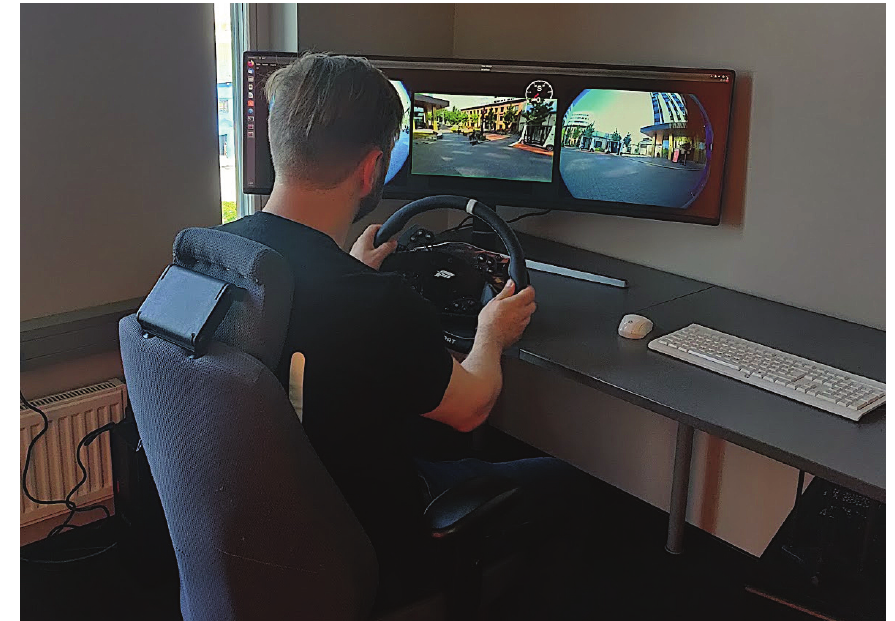
Fig. 2. Teleoperation in Ülemiste remote operation